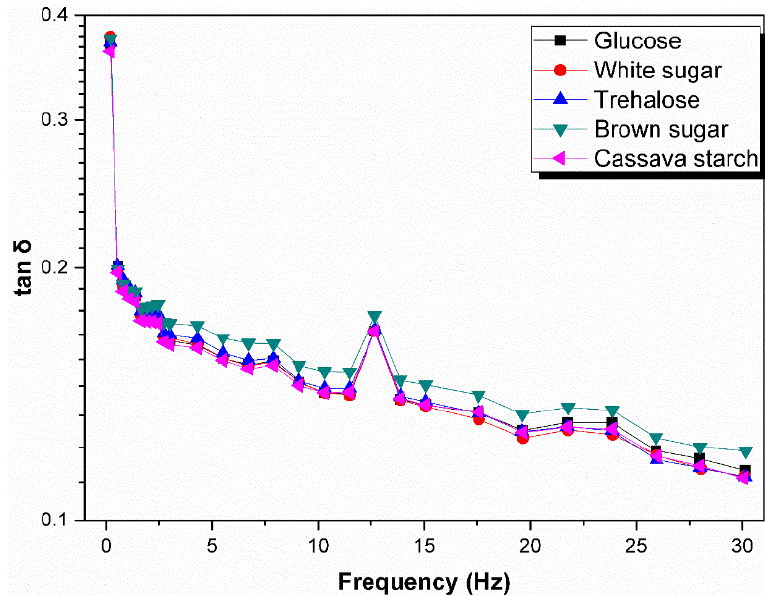
Figure 7. Tanδ as function of frequency of raw natural rubber resulted from different sugars . Figure 7. Tan δ as function of frequency of raw natural rubber resulted from different